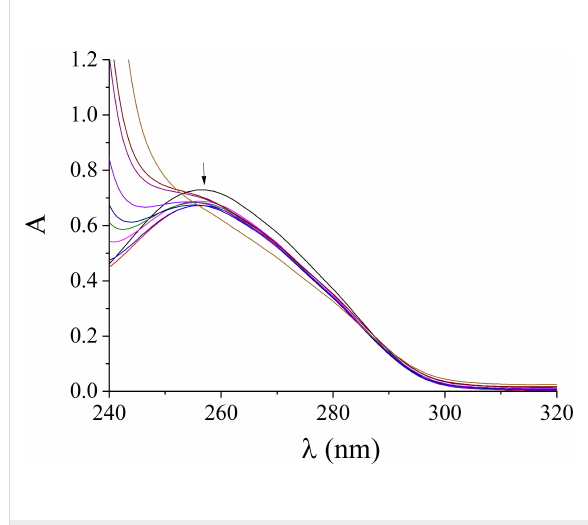
Figure 2: UV–vis spectra of CT DNA ([DNA] = 1.1 × 10 − 4 M) in buffer solution in the absence or presence of increasing amounts of com- pound 11 ( r = 0–0.8). The arrow indicates the changes with increasing amounts of the